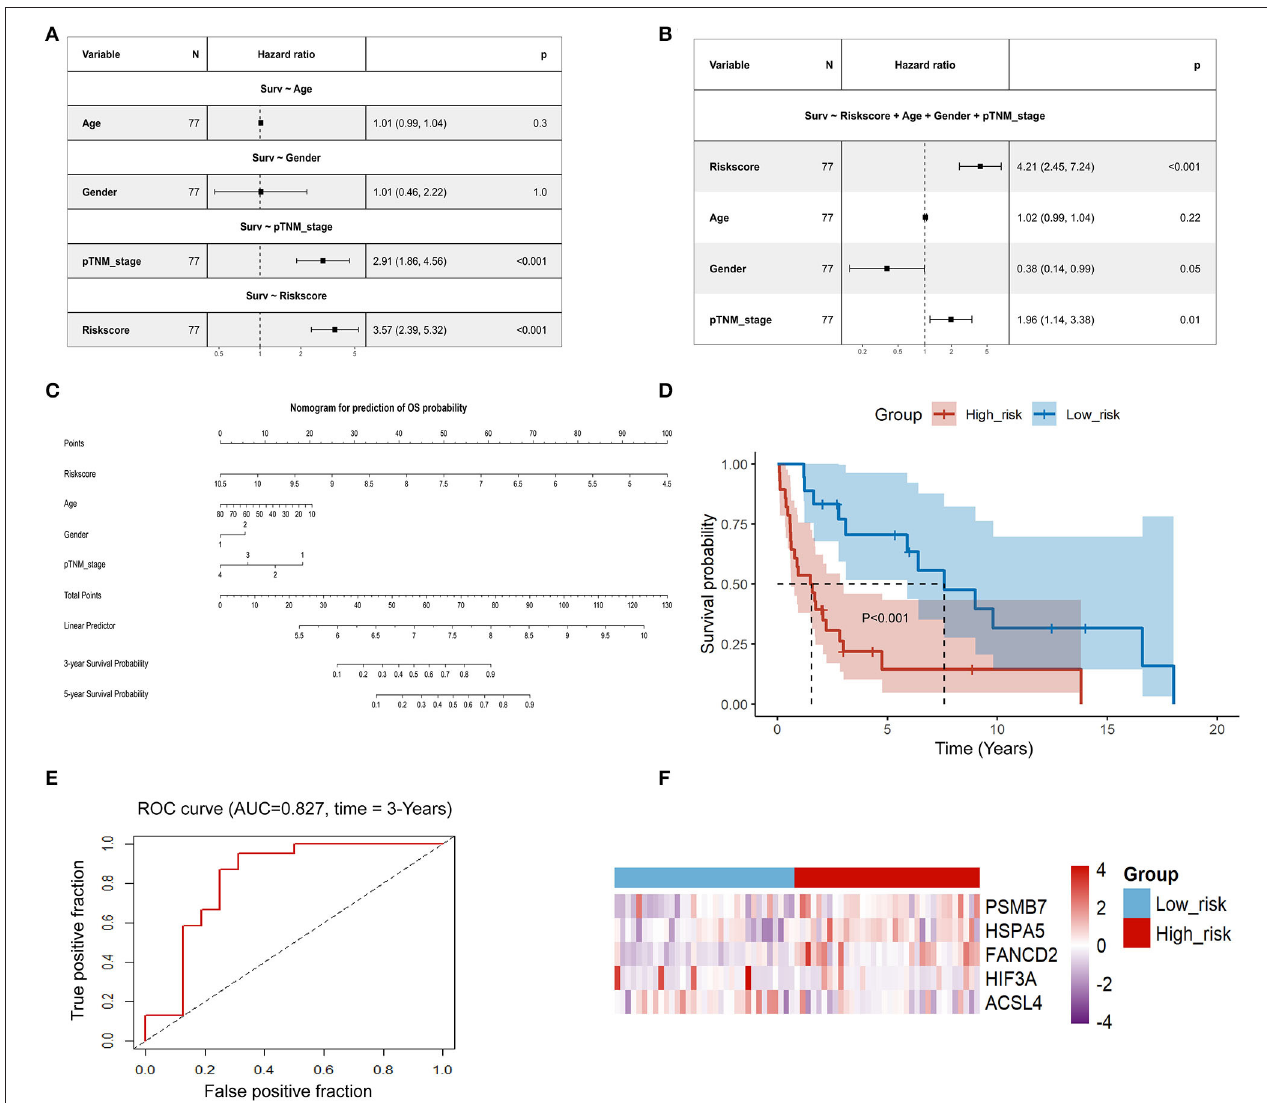
FIGURE 7 | Evaluation of the reliability and the stability of the predictive model in ACC. (A) Univariate Cox regression analysis of age, gender, stage, and risk score in the TCGA-ACC set; (B) Multivariate Cox regression analysis of age, gender, stage, and risk score in the TCGA-ACC set; (C) A nomogram for prediction of OS probability; (D) Kaplan-Meier analysis of the gene signature in pooled data from the GSE19750 dataset and the GSE10927 dataset; (E) Time-dependent ROC analysis of the gene signature in pooled data from the GSE19750 dataset and the GSE10927 dataset; (F) Heatmap of the expression profiles of 5 prognostic genes in low-risk and high-risk group in pooled data from the GSE19750 dataset and the GSE10927 dataset. ACC, adrenocortical carcinoma; TCGA, The Cancer Genome Atlas; OS: overall